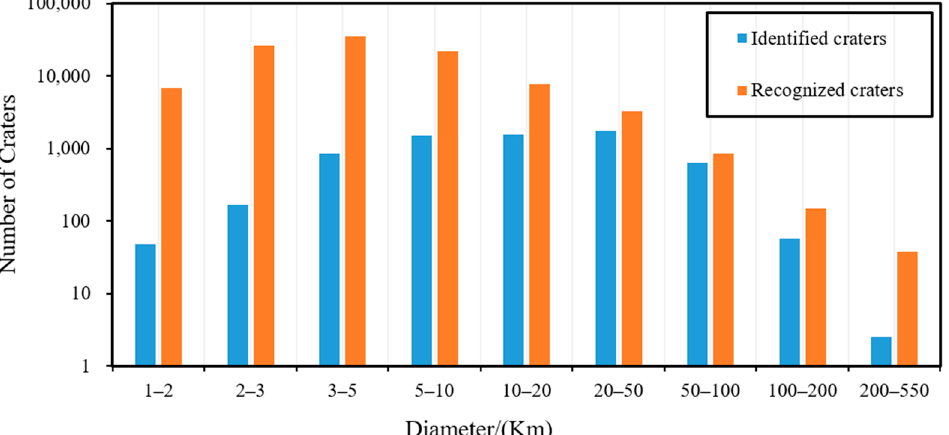
Figure 9. Comparison of the distribution of lunar craters with different diameters identified by the IAU. (The yellow column represents the number of craters recognized by the model. The blue column represents the number of identified craters.).